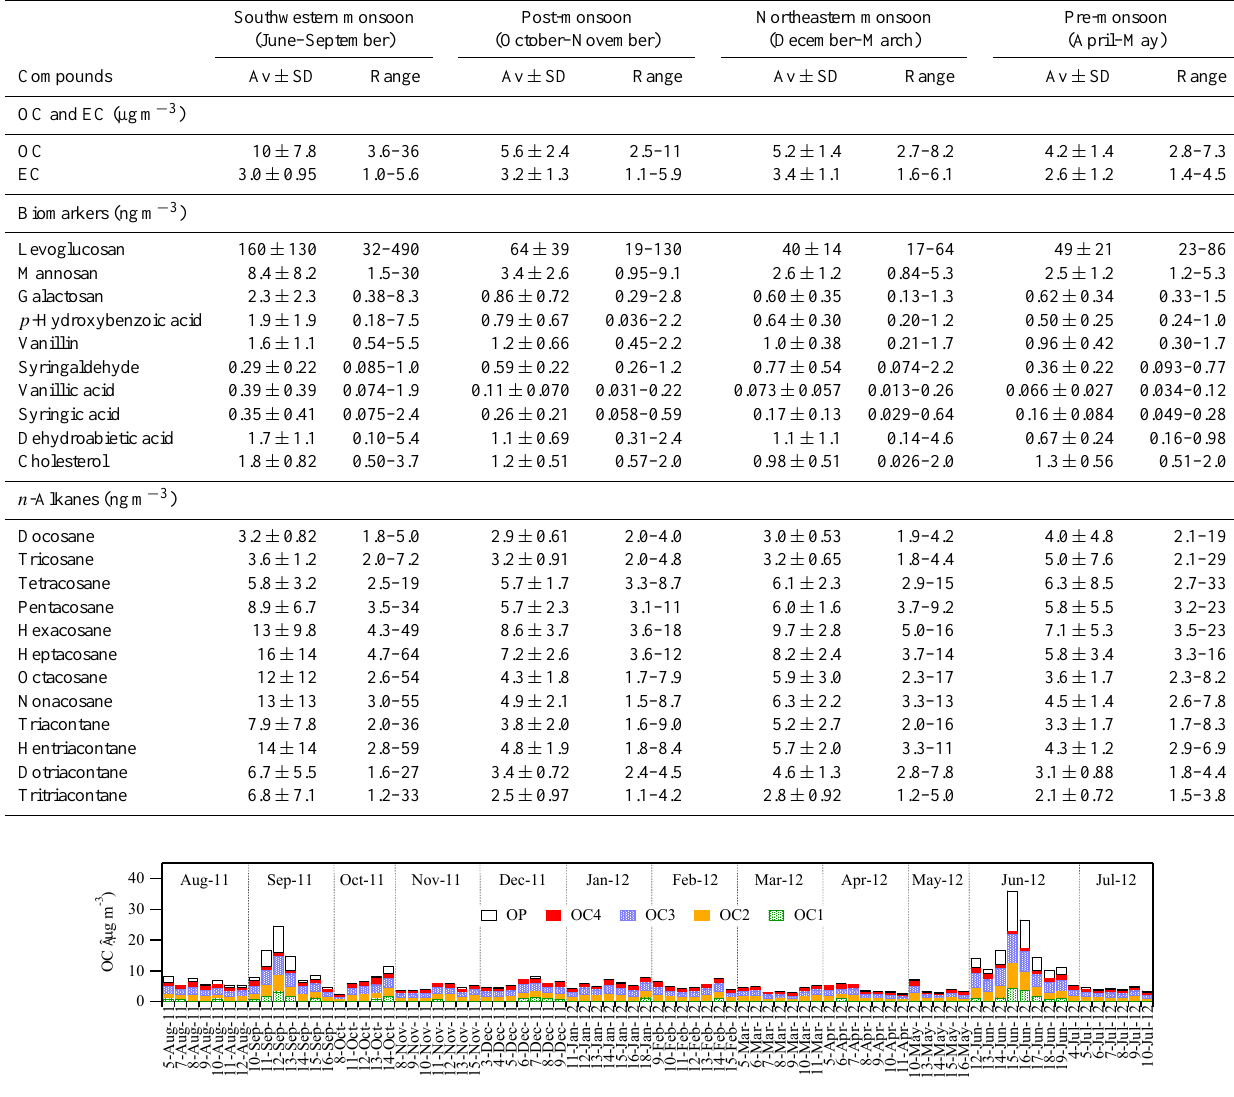
Figure 3. Daily variation of the OC fractions’ mass concentrations during the sampling periods.